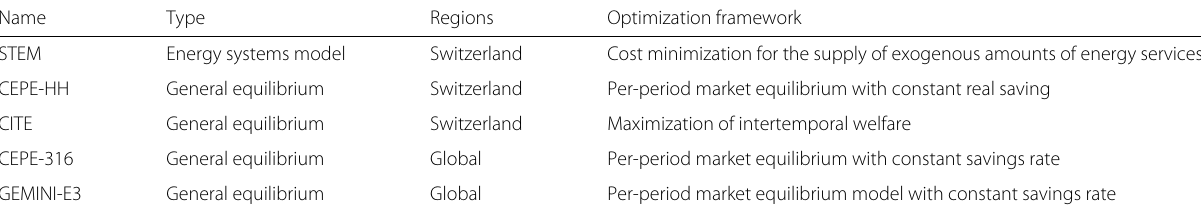
Table 4 Key features of models participating in the Swiss Energy Modeling